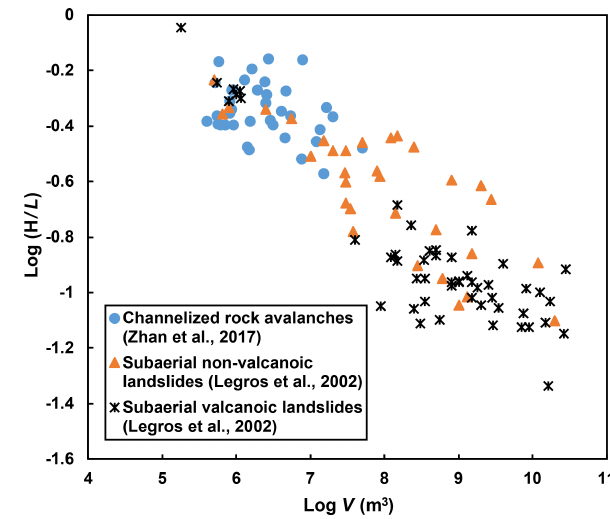
Figure 13. Relationship between the volume and H/L ratio of different-type landslides from the worldwide dataset (Legros,